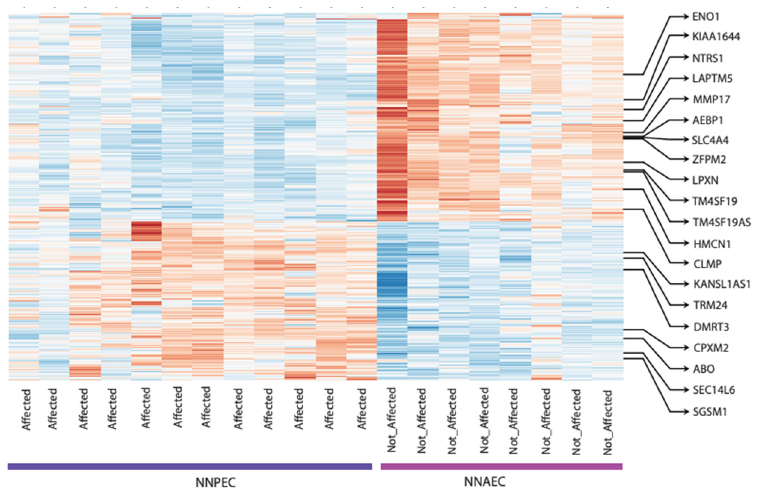
(Table 3), plasma membrane organisation, macroautophagy, leukotriene metabolic pro- cess, protein localisation to the membrane, drug catabolic processes, and neuron cell-cell adhesion. In addition, the Pathview toolset (Bioconductor) was used for pathway-based data integration and visualisation (Table 4). The data discussed in this publication have been deposited in NCBI’s Gene Expression Omnibus [14] and are accessible through GEO Series accession number GSE158277.